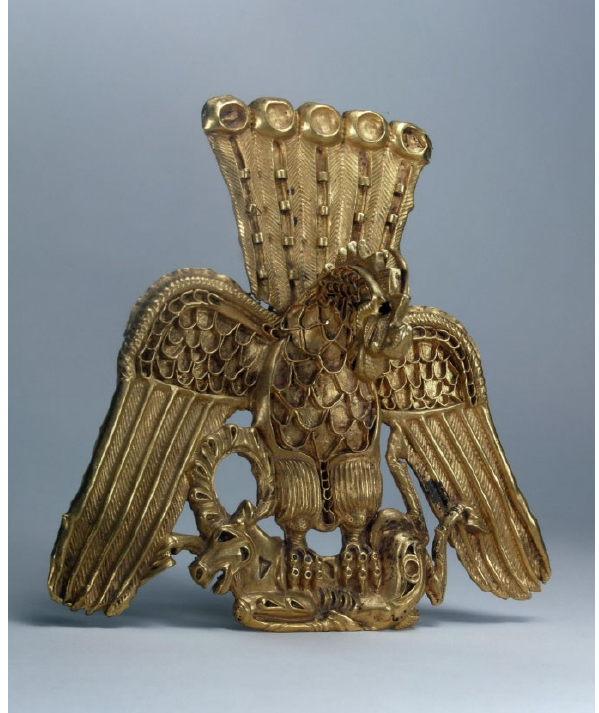
Figure 10. Gold headdress ornament (aigrette) with a fantastical eagle predating on an ibex (SHM inv. no C и .1727 ‐ 1/131); gold with turquoise inlays; Siberian Collection of Peter I; 4th to 3rd century BC. [Image is used from www.hermitagemuseum.org (accessed 9 November 2022), courtesy of the State Hermitage Museum, St. Petersburg, Russia].